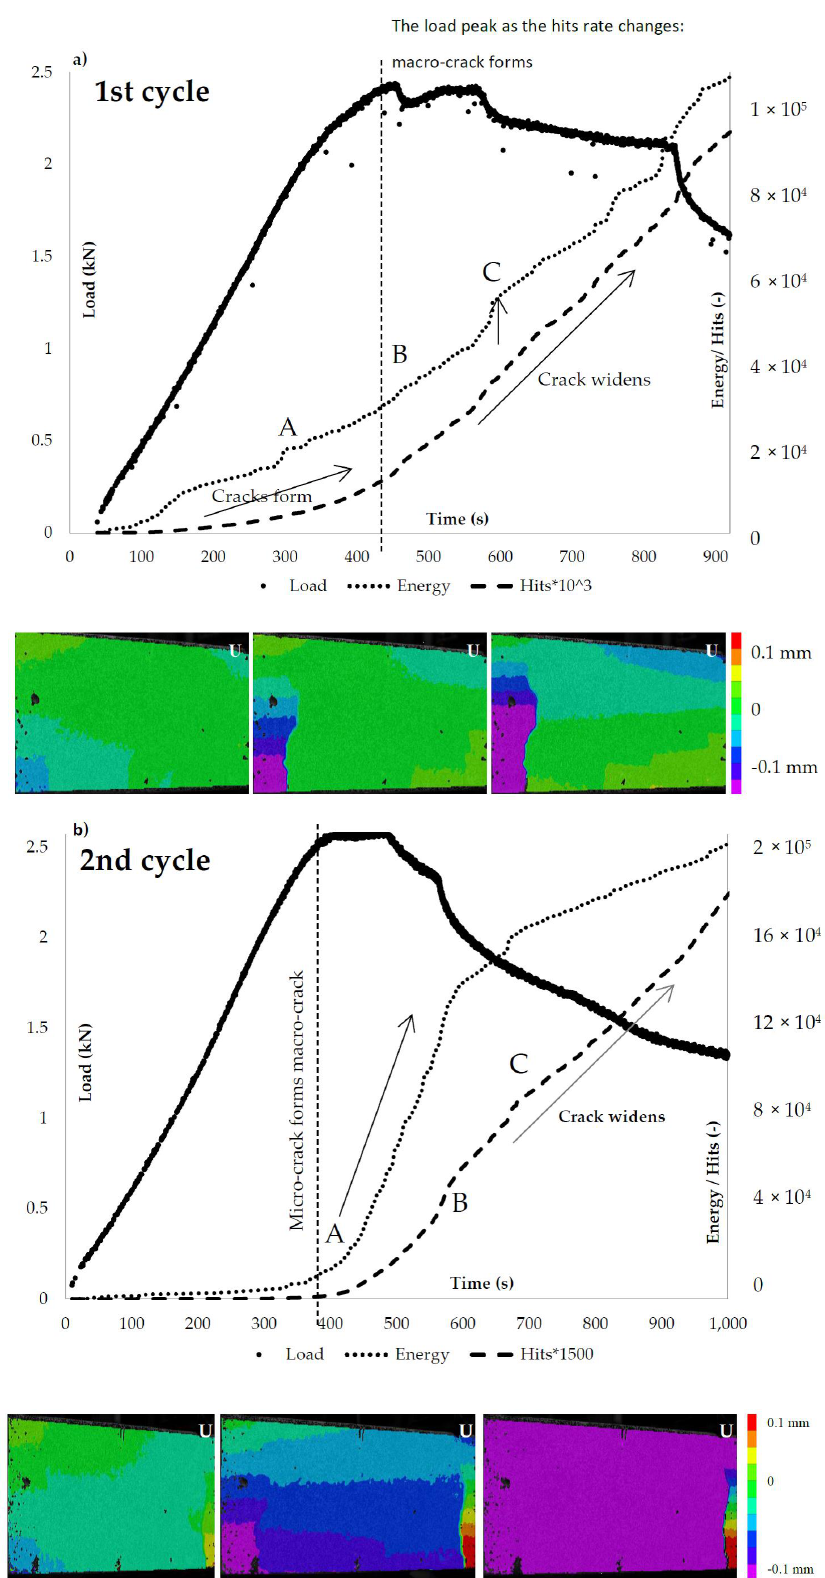
Figure 8. The ceramic (alumina) vascular system load response and AE hits activity: ( a ) loading (1 st cycle); ( b ) reloading (2 nd cycle).